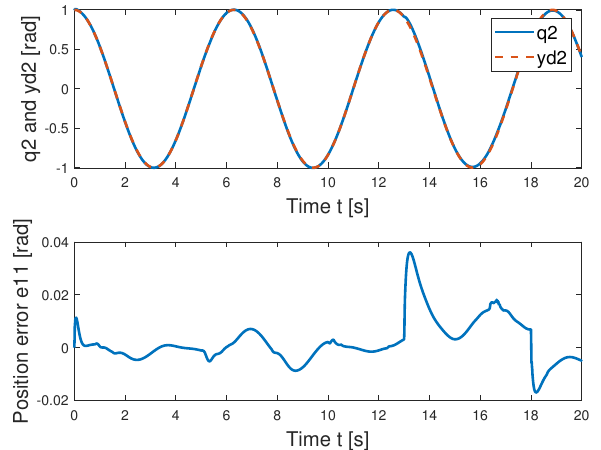
Figure 8. q 1 position trajectory and tracking error e 11 (NNs-based control).